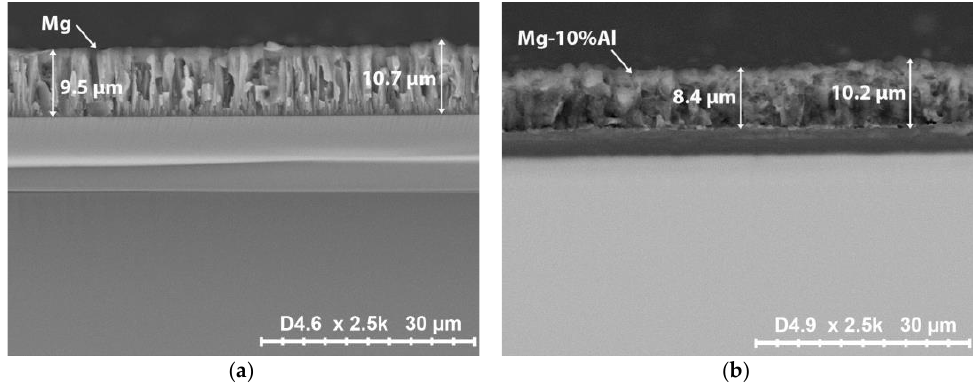
Figure 4. SEM images of a transverse cleavage of ( a ) Mg coating; ( b ) Mg-10%Al coating.